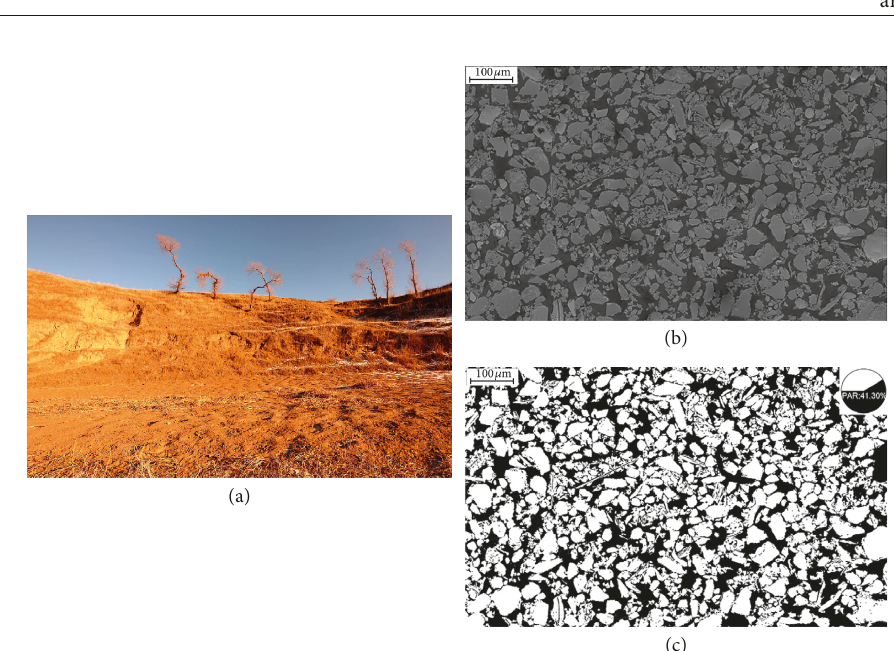
Figure 1: SEM image of loess (the pore area ratios are shown at the top right corners) [42]. (a) Loess. (b) Loess SEM image. (c) Loess SEM binary